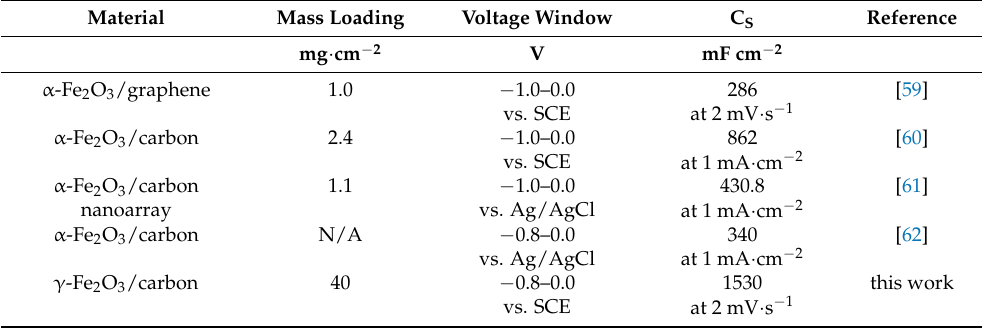
Table 1. Capacitance of Fe 2 O 3 -based composites containing conductive carbon additives in Na 2 SO 4 electrolyte in negative potential